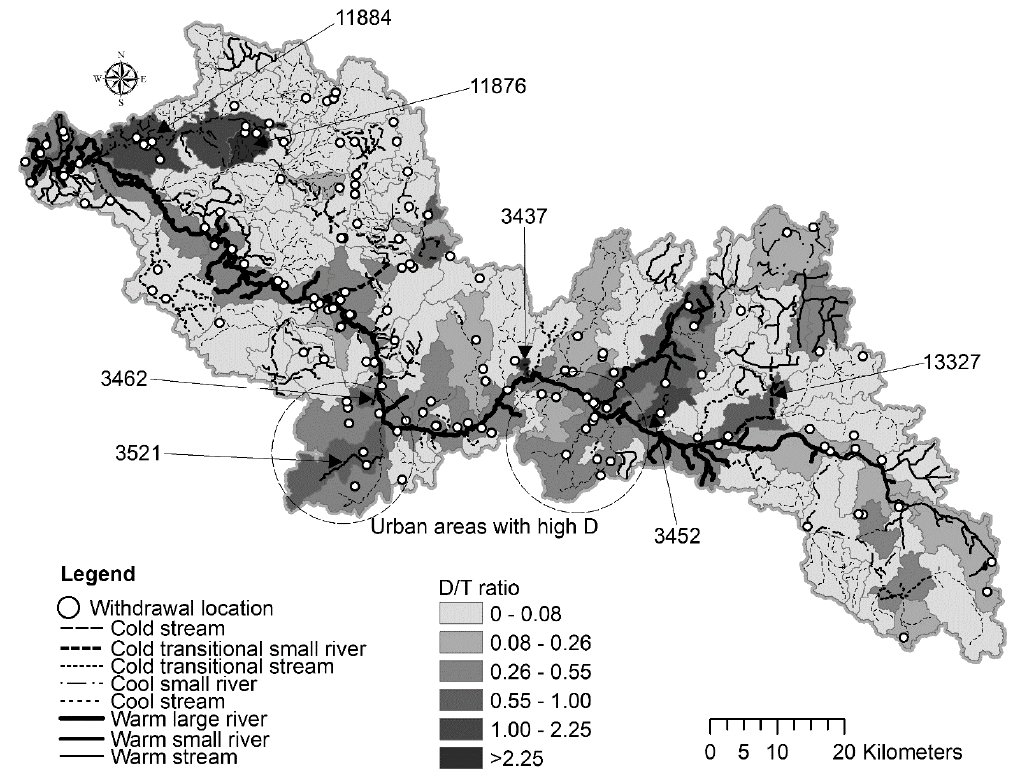
Figure 2. Ratio of the surface water flow (Blue) Water Footprint ( BWF = D = F T ) to the streamflow depletion threshold, T, for each stream segment of the Kalamazoo River in Michigan, USA. Dark grey colors where D / T > 1 indicate the presence of scarcity where F T > 0. This is Figure 5 [59] reproduced with permission of ASCE Press and the Authors.